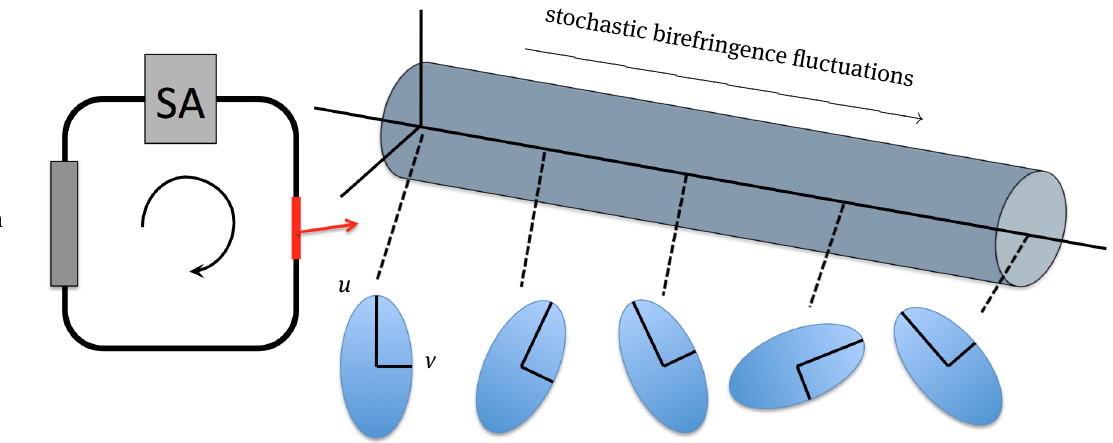
Figure 3: Schematic of a mode-locked laser cavity which includes a ring fiber with saturable absorber (SA) and gain element. (B) The SA is generated by nonlinear polarization rotation interacting with three waveplates ( α j where j = 1, 2, 3 ) and a polarizer ( α p ). Incoming polar- ized light ( P − ) is attenuated by the polarizer if it is not in alignment with the transmitting axis. Thus only a single polarization direction ( P + ) is transmitted. (C) The fiber itself is subject to stochastic fluctuations in the birefringence, i.e. random rotations of the principal fast- and slow-axes, u and v respectively. Shown is an example portion of fiber where the rotations depend sensitively on bend, twist, anisotropic stress and/or ambient